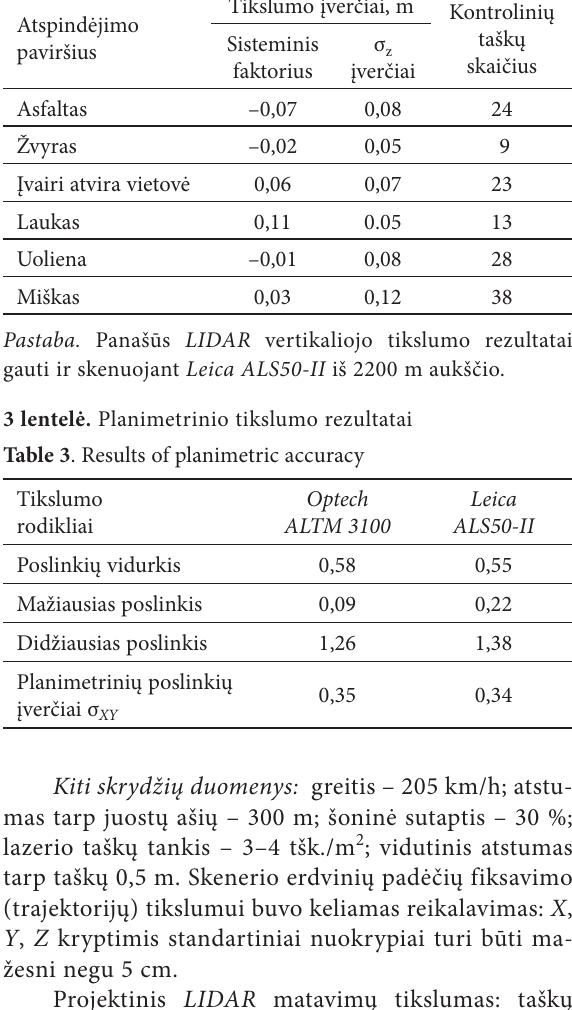
Table 2. Accuracy of pulse reflection’s heights points Atspindėjimo